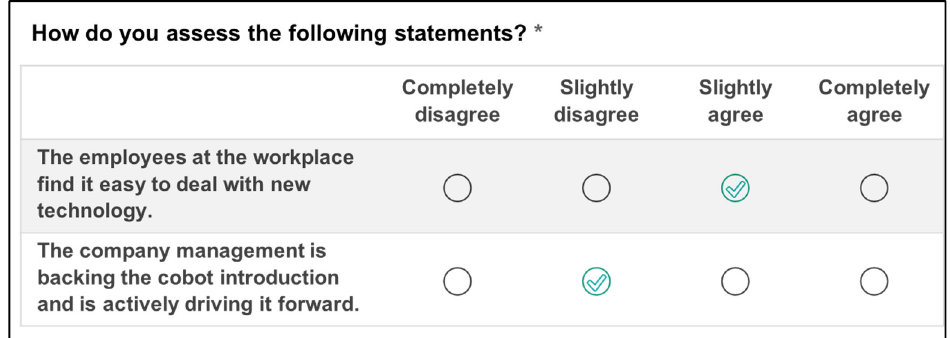
Figure 2. Example for the query of data in phase 1.